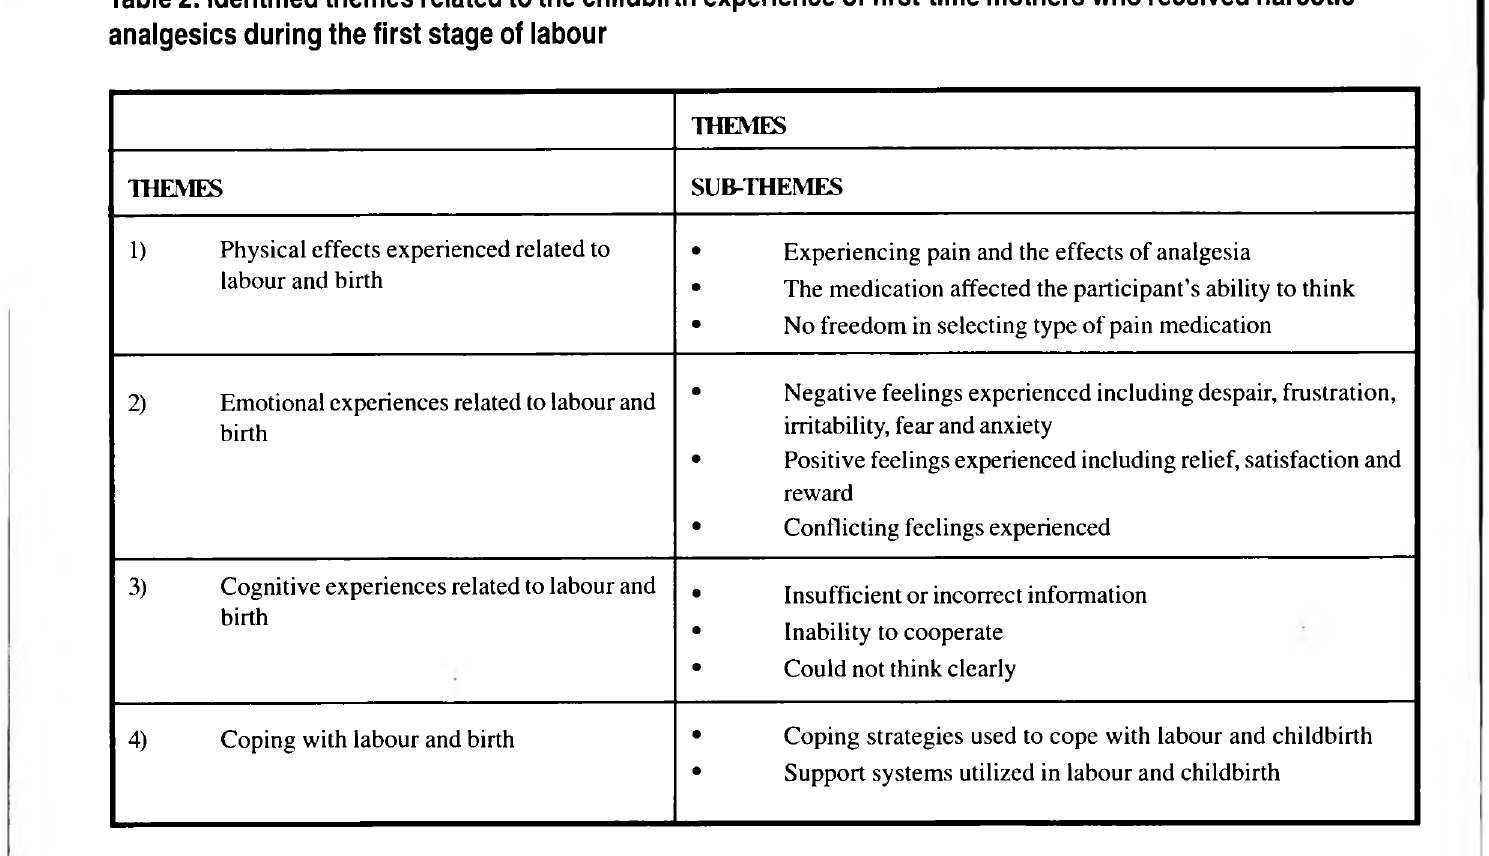
Table 2: Identified themes related to the childbirth experience of first-time mothers who received narcotic analgesics during the first stage of